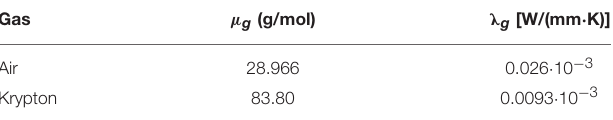
TABLE 2 | The properties of the interstitial gases (Dorf, 2003).